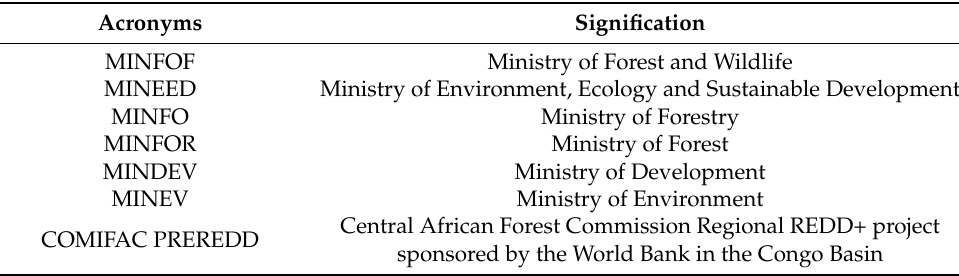
Table A2. List of selected institutional